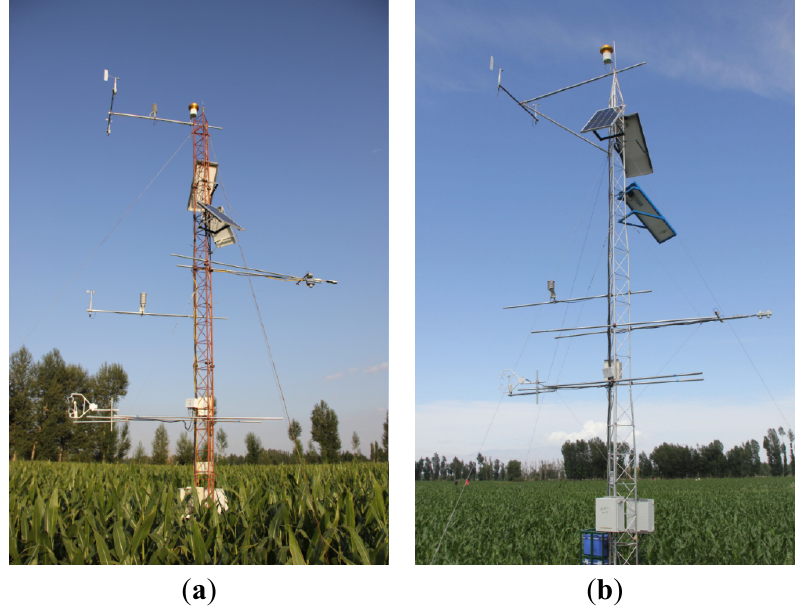
Figure 1. Land cover and the meteorological instrument locations in the study area.